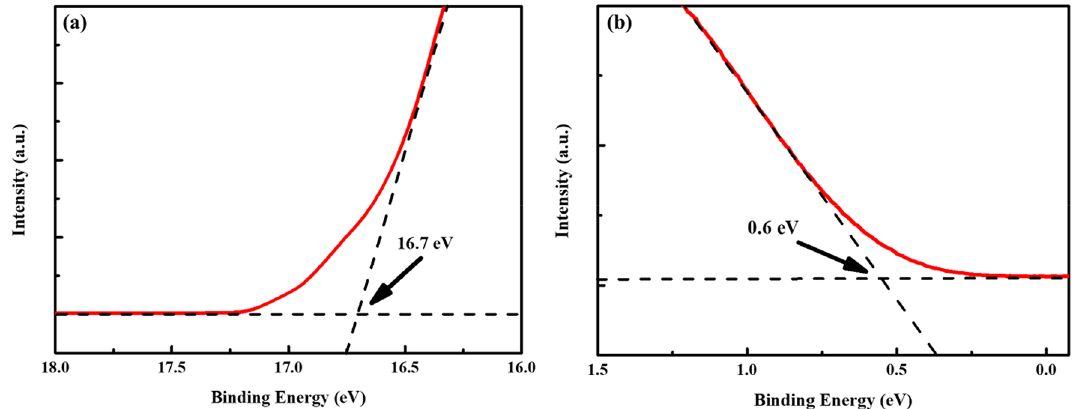
Figure 4. UPS spectra of ZnCo 2 O 4 NPs at ( a ) high and ( b ) low binding energy regions. The E F is obtained as E F = − (21.22-high binding energy cutoff), and VB is calculated as VB = E F -low binding energy